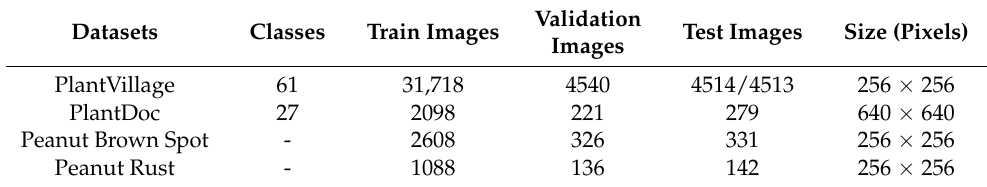
Table 2. The specific parameters of the dataset in this study (including the dataset of the model evaluation test and the transfer learning